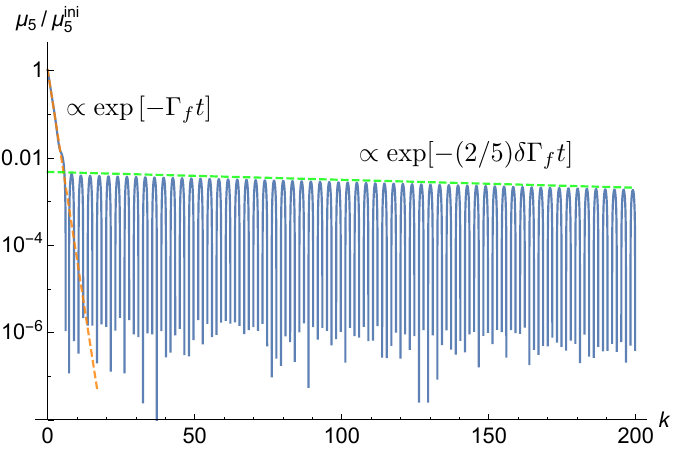
Figure 2. Numerical calculation of the solution to eq. (3.20) in the earlier times with Γ f = k and δ = 0 . 01 . For t . 1 / Γ f , the initial asymmetry is washout in a rate proportional to exp[ − Γ f t ] . For t (cid:29) 1 / Γ f , the backreaction dominates and the chiral chemical potential shows the slowly decaying oscillation in proportion to exp[ − cδ Γ f t ] with c ’ 2 / 5 in this parameter